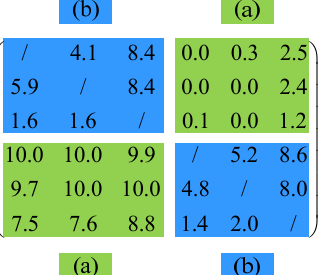
Table 7. The calculation results of area (Order of magnitude 7 10 × ).